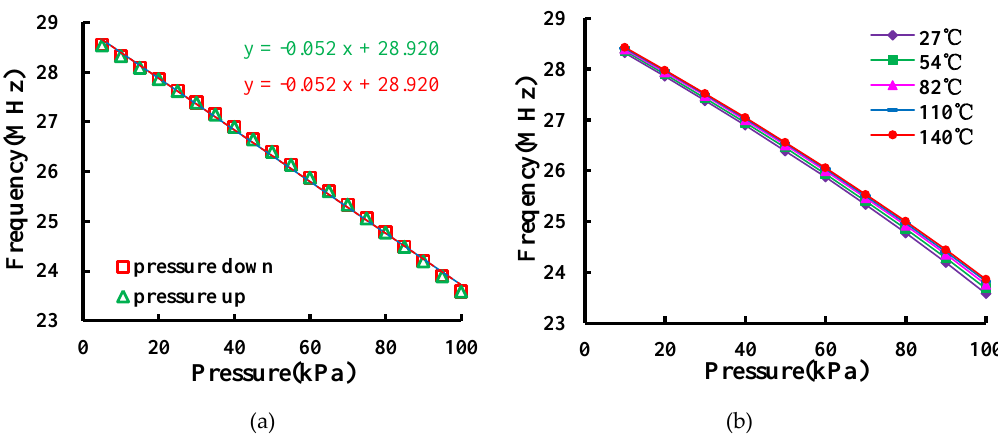
Figure 7 . Frequency-pressure measurement system